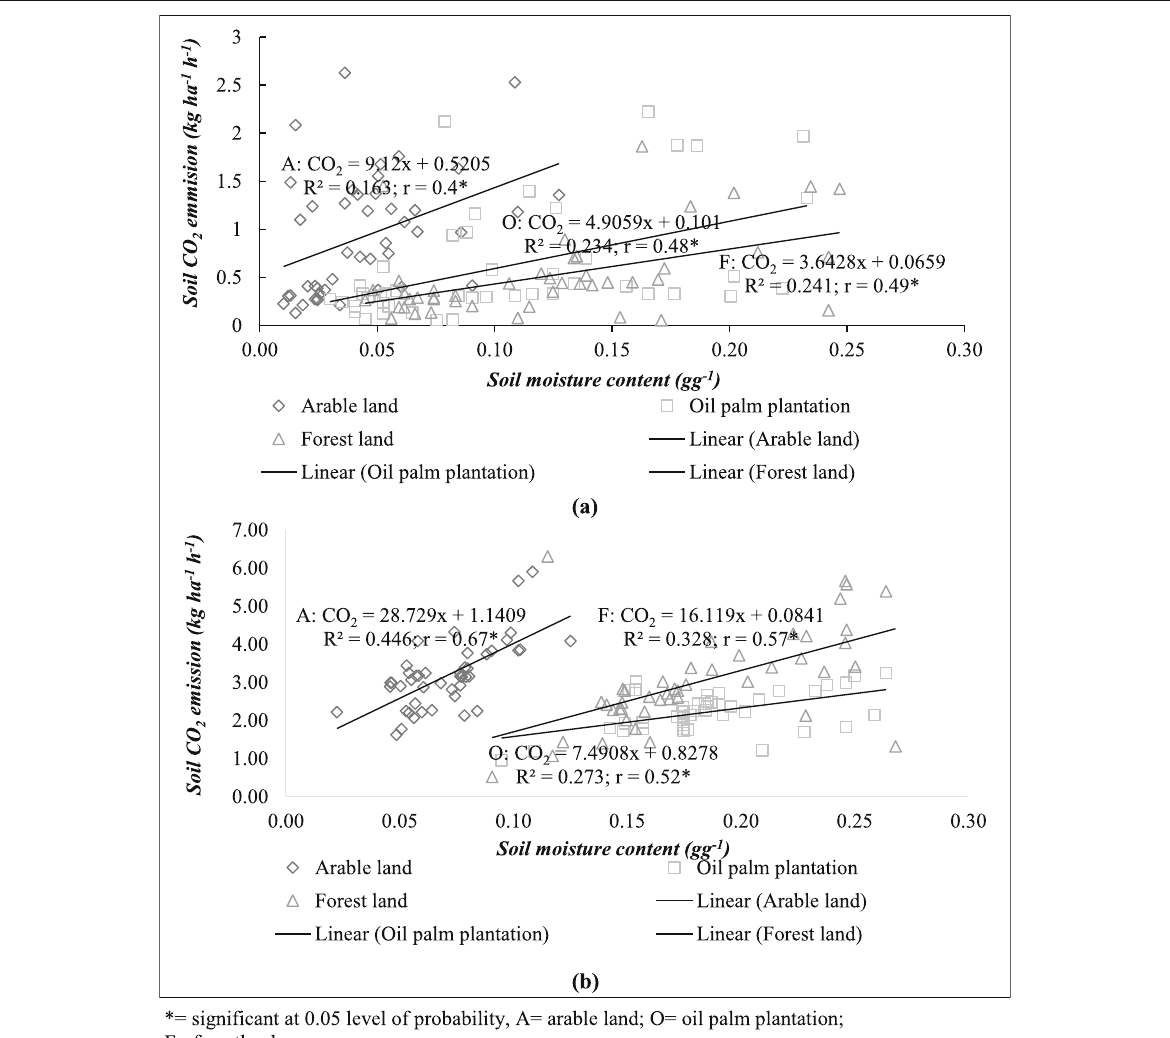
Fig. 5 Relationships between soil moisture and CO 2 production in the land use systems for both dry ( a ) and wet ( b )